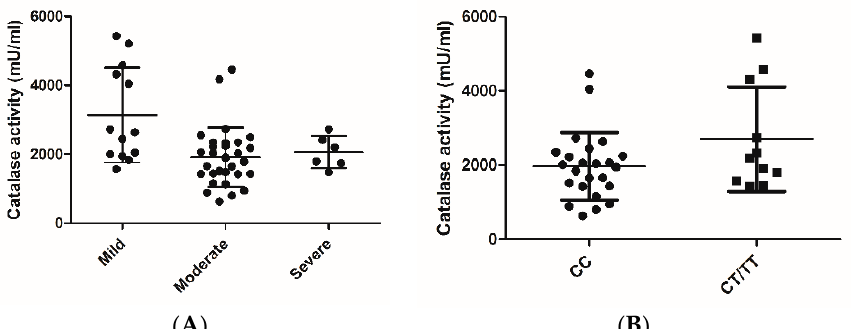
Figure 1. ( A ) Catalase activity in nasopharyngeal secretions (NPS) of infants with respiratory syncytial virus (RSV) lower respiratory tract infections (LRTI) of different severities (mild, moderate, severe). NPS obtained from RSV-positive LRTI patients were tested for catalase activity. Assays were performed on samples in a blinded manner by using numerical identifiers, and activity was determined after volume/protein normalization. Statistics were determined by using a one-way ANOVA, with p < 0.05 for moderate-plus-severe vs mild. ( B ) Catalase activity in the NPS of infants with RSV LRTI according to the presence of the CC or CT/TT allele. Statistics were determined by using one tailed t-test with Welch’s correction.